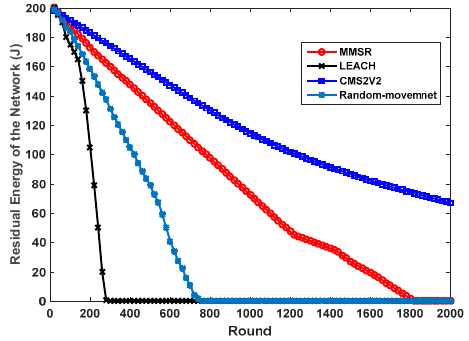
Figure 10. Residual energy comparison.